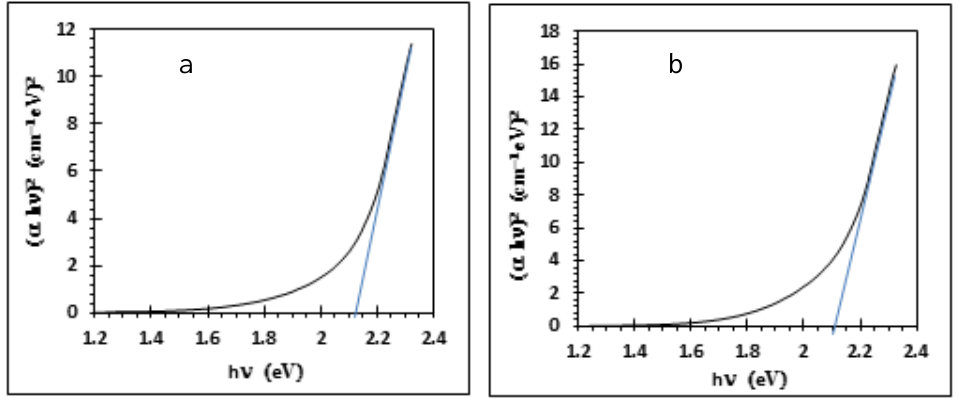
Fig. 7: The optical energy bandgap for the AuNPs prepared at different laser energy, a: 60 mJ and b: 600 mJ.